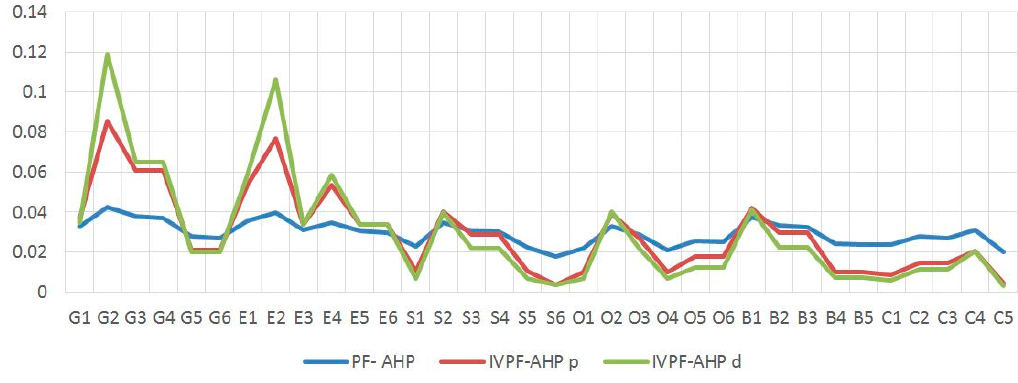
Figure 7. Graphic representation of the final weights ranking of sub-criteria. The obtained results indicate the dominance of two sub-criteria in the algorithm, G2 and E2. Additionally, the first three indicators are the same for all three methods, and two interval methods have overlaps in the order of the first seven indicators. The final ranking results, obtained by the consistent application, are shown in Table 17. Table 17. Final ranking of indicators.